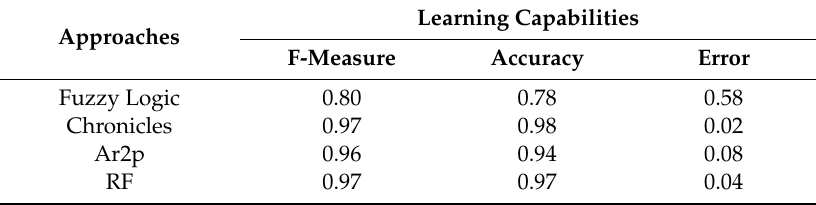
Table 13. Results of the Learning Capabilities with missing data during the training